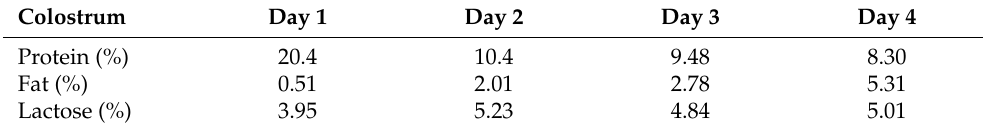
Table 6. Chemical composition of alpaca colostrum during the first 4 days post-partum. Colostrum Day 1 Day 2 Day 3 Day 4 Protein (%) 20.4 10.4 9.48 8.30 Fat (%) 0.51 2.01 2.78 5.31 Lactose (%) 3.95 5.23 4.84